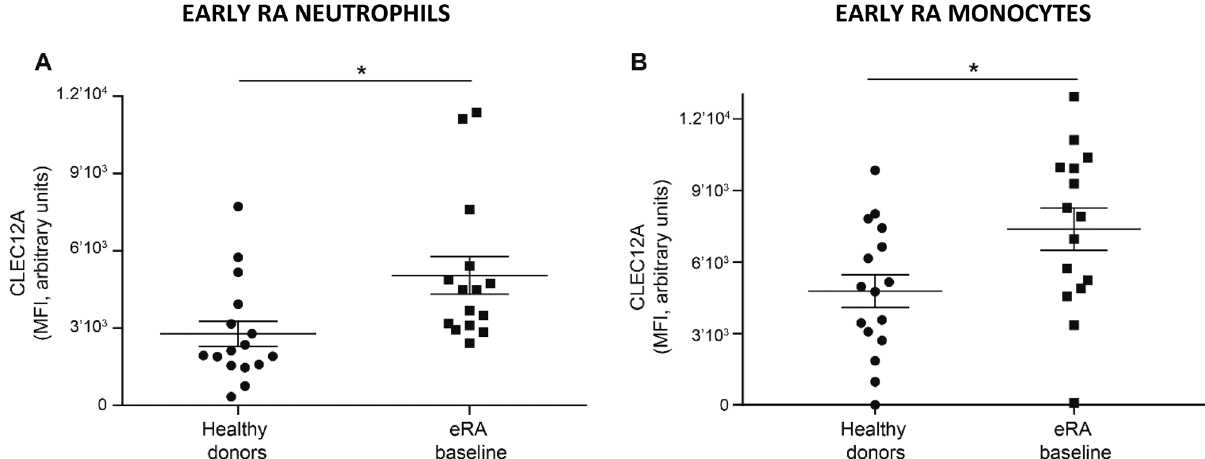
Figure 4. CLEC12A is differentially expressed on eRA neutrophils and monocytes compared to healthy donors. CLEC12A expression was measured by flow cytometry on peripheral neutrophils and monocytes of eRA patients and healthy donors. (A) Comparison of neutrophil CLEC12A expression of healthy donors and eRA patients at baseline (Student’s t -test, p = 0.014). (B) Comparison of monocyte CLEC12A expression of healthy donors and eRA patients at baseline (Student’s t test, p = 0.026). Symbols represent individual subjects. Data show the mean ± SEM. *** < 0.001 ** < 0.01 * <